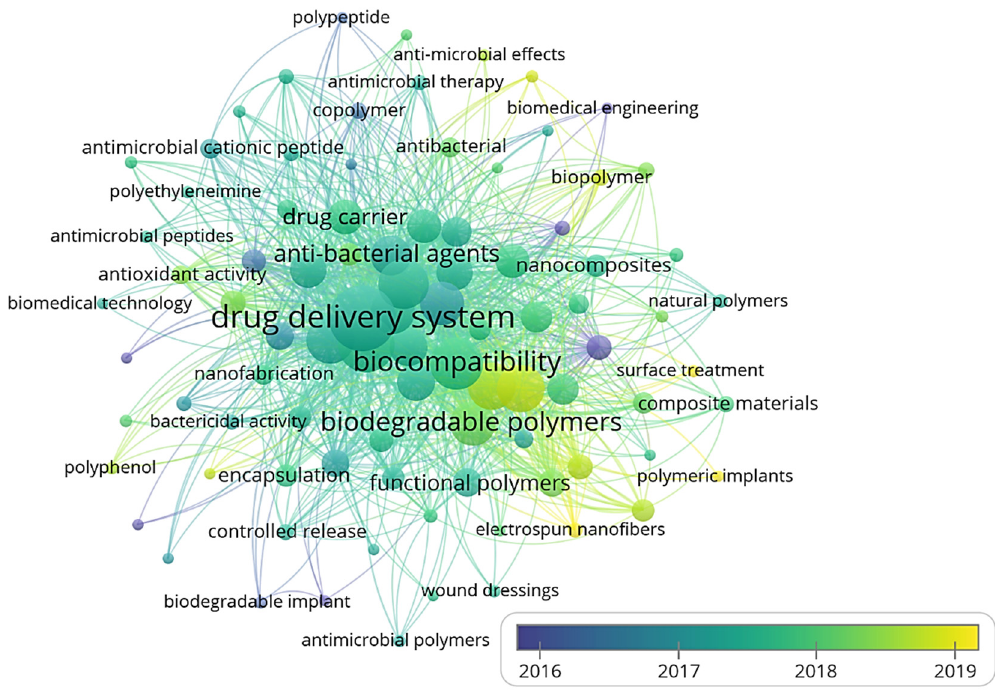
Figure 34. Bibliometric mapping of the antimicrobial drug delivery of biodegradable and natural polymeric biomaterials in hard tissue engineering.